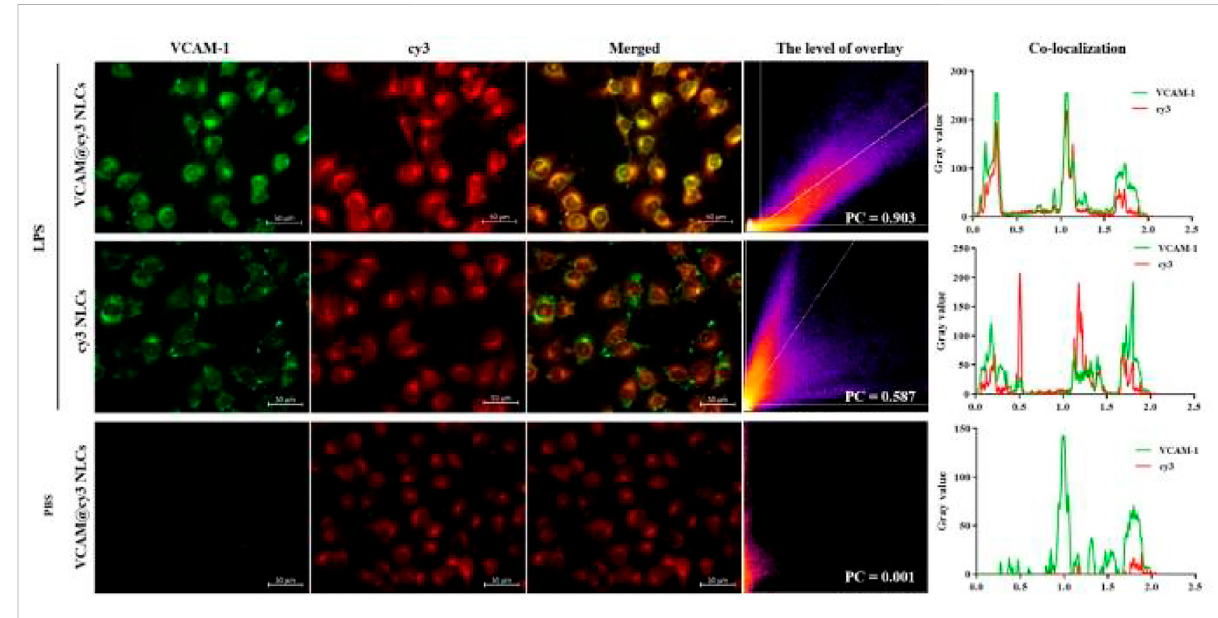
FIGURE 5 Colocalizationanalysisbetweency3-labelledVCAM-1antibody-conjugatedNLCs(red)andVCAM-1receptor(green),includinglevelofoverlay and Pearson ’ s correlation coef fi cient. (Scale bar, 50 μ